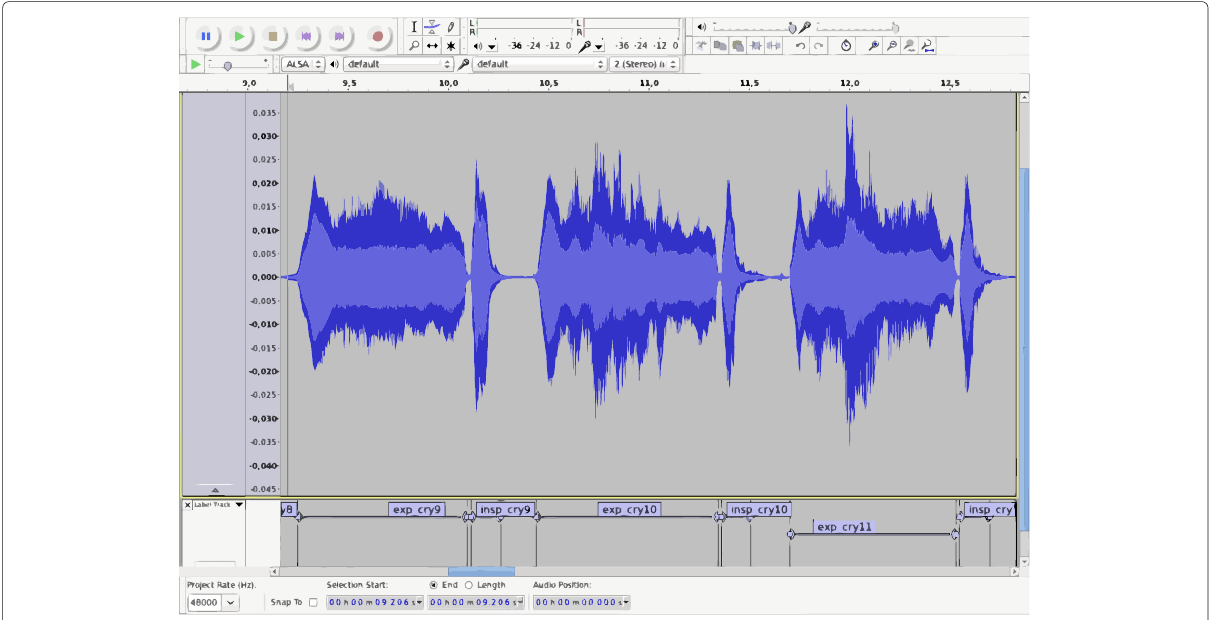
Fig. 8 Snapshot of the Audacity application showing a manually annotated chunk of the cry recording. Expiratory and inspiratory phases are coded by names exp_cry and insp_cry ,